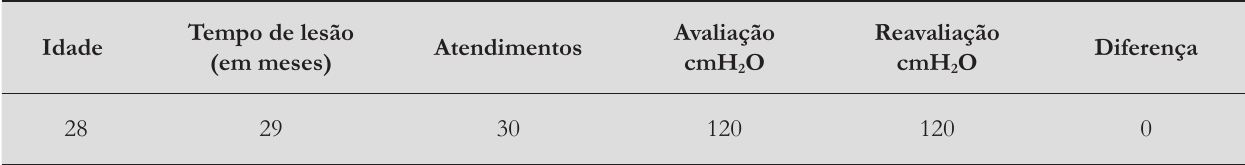
Tabela 3 - Resultados apresentados pelo sujeito